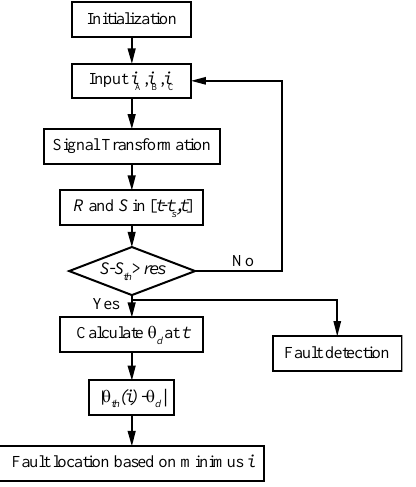
Figure 8. Fault detection and location algorithm flow chart based on current residual.